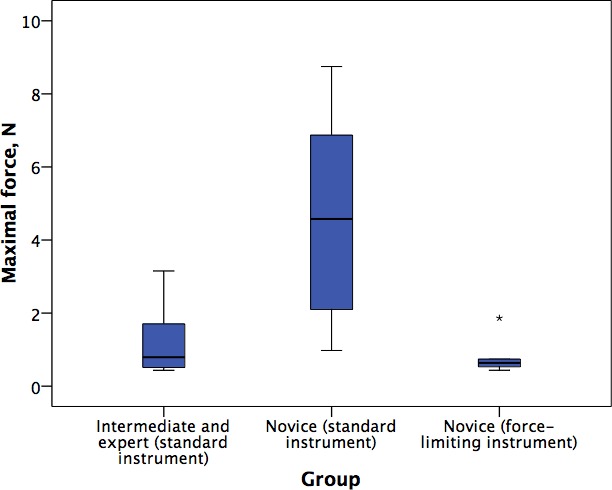
Maximum forces exerted by: intermediates and experts using the standard instrument; novices using the standard instrument; and novices using the force-limiting instrument.Points represent outliers (star greater than 3 times the interquartile range).